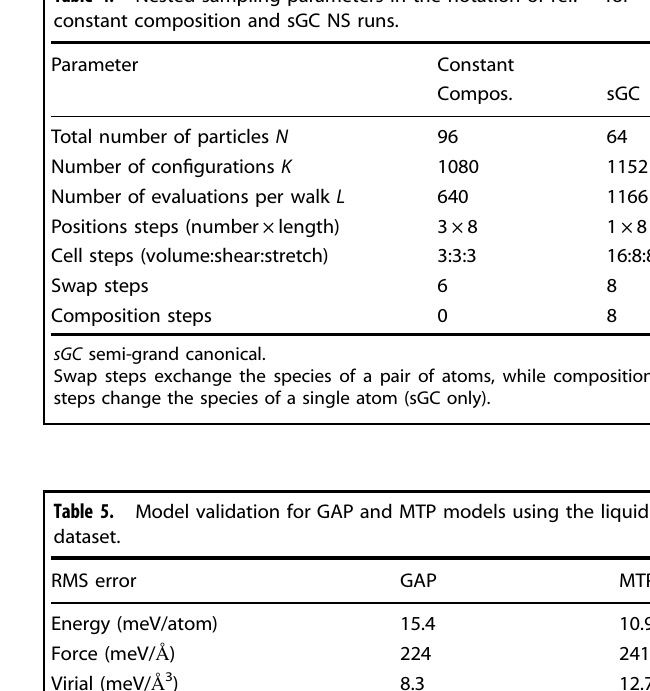
Table 2. Parameters for the GAP-SOAP (many-body) term.